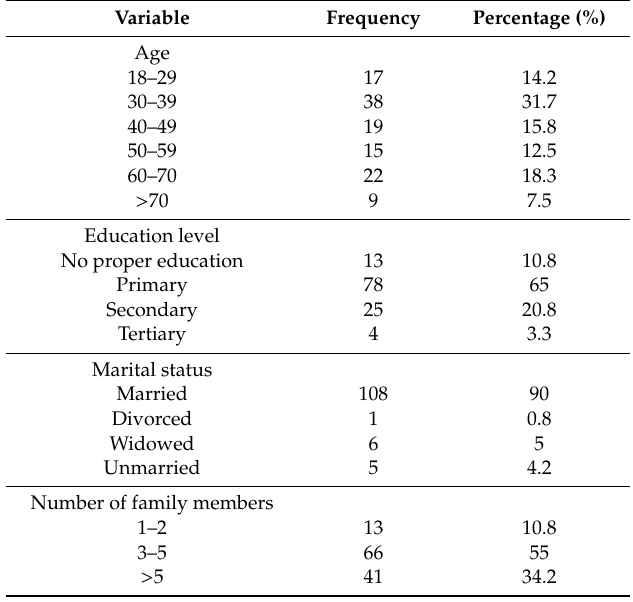
Table 1. Socio-economic and health-related characteristics of the study